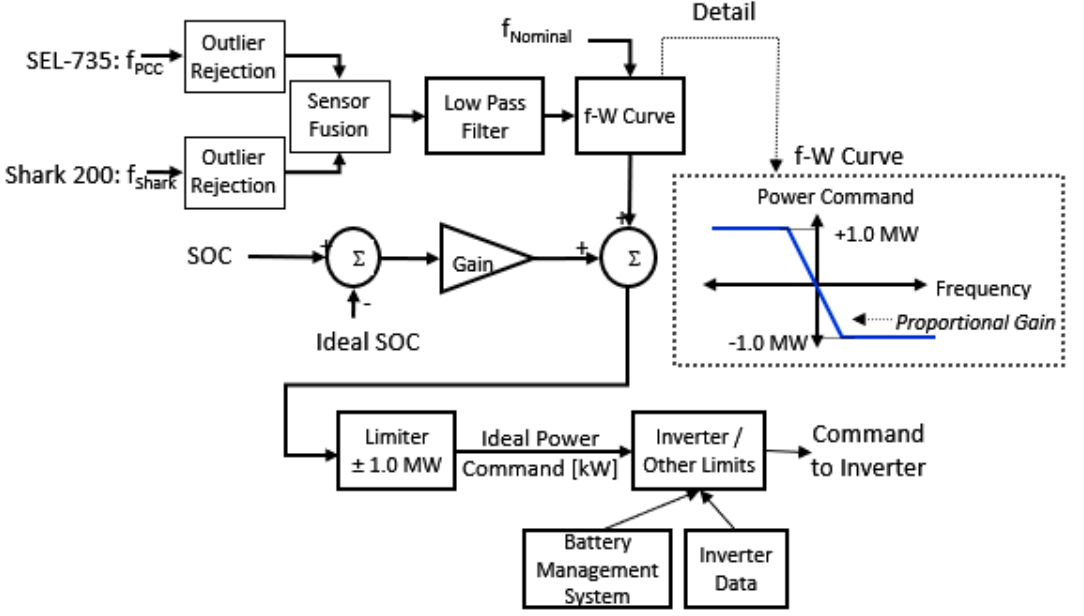
Figure 4. Schematic of the frequency response control algorithm.